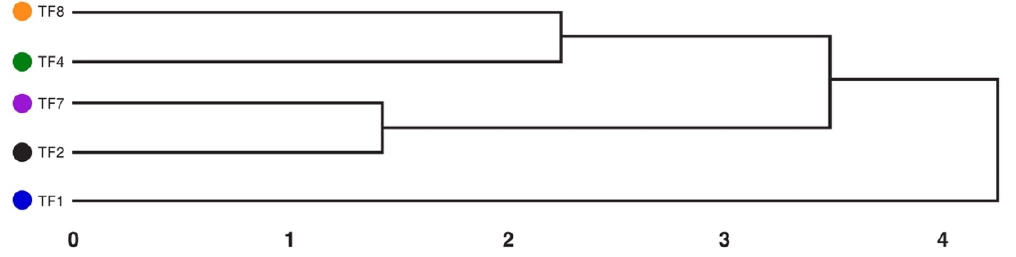
Figure 9. Cluster analysis of similarity in abiotic stress tolerance of Trifolium fragiferum plants of different accessions. Data are from Table 4. Euclidian distance with UPGMA clustering was used.